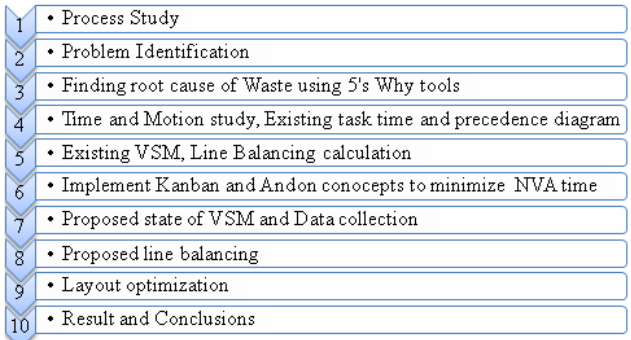
Fig. 1. Flow chart of the proposed